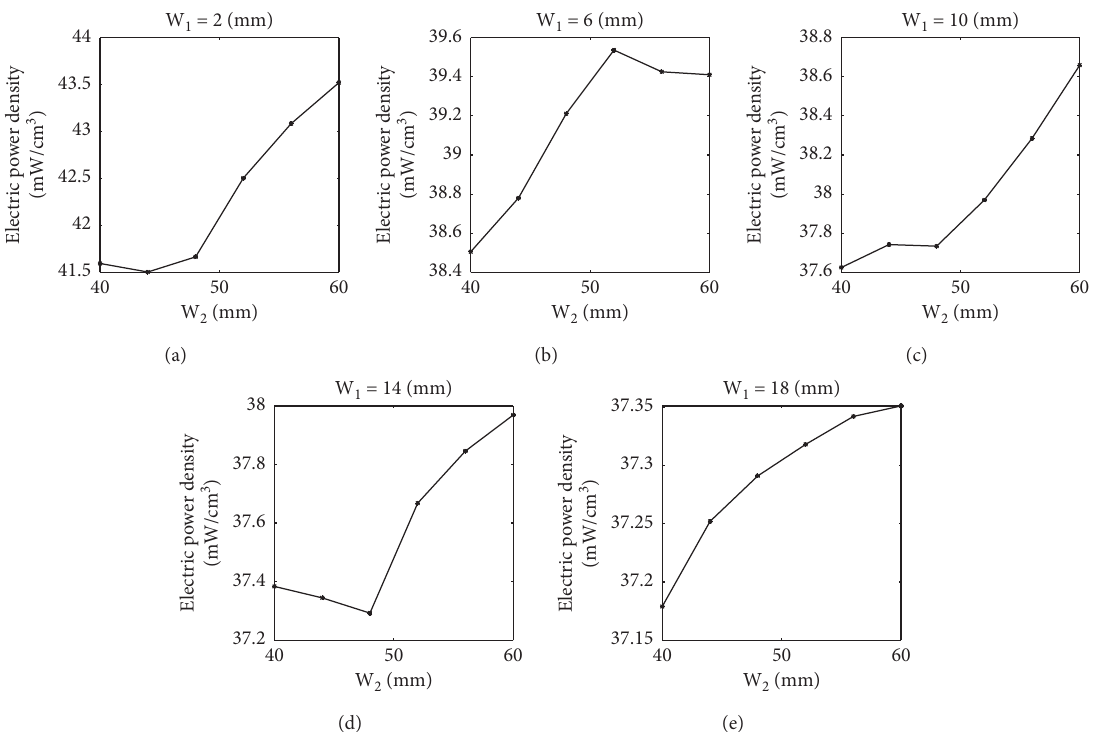
Figure 12: The maximum electrical power density of 30 various geometries of the trapezoidal two-piece composite piezoelectric bimorph beam (second design), in a closed circuit with the optimal resistor load. The length of the beam L is 60mm, the thickness of T piezo is 0.3mm, and the thickness of the brass layer T s is